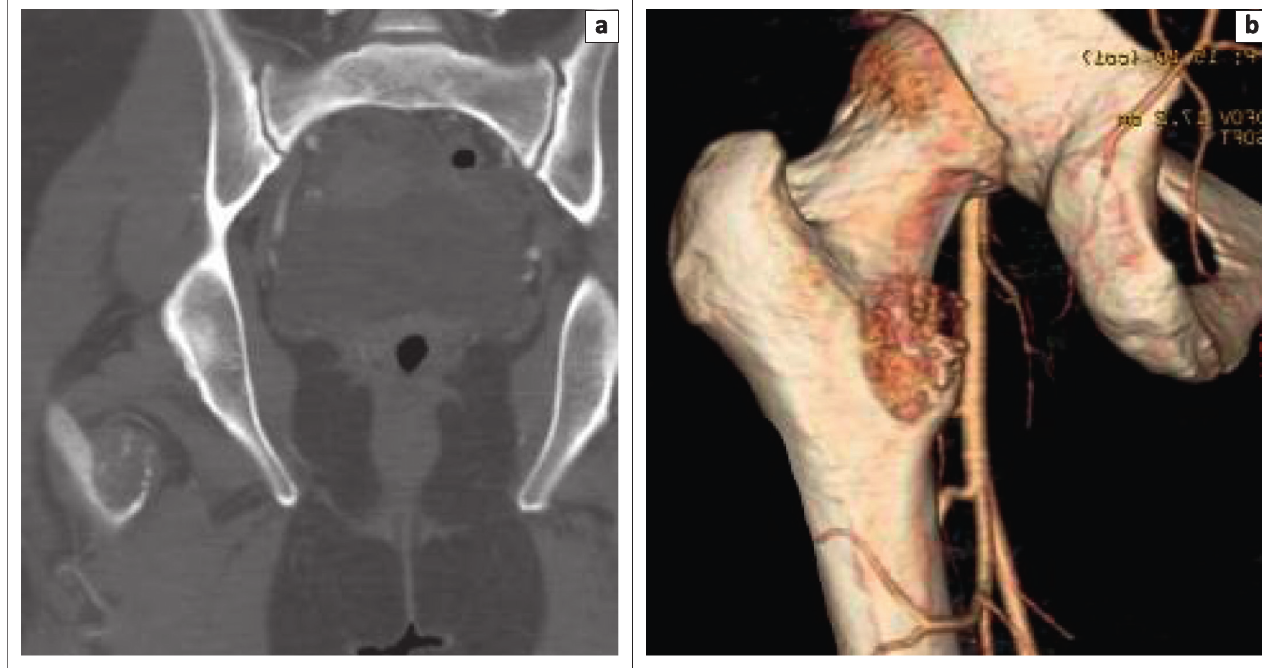
FIGURE 6: Coronal CT reformat image (a) of the right hip, and volume-rendered CTA reformat (b) of the right